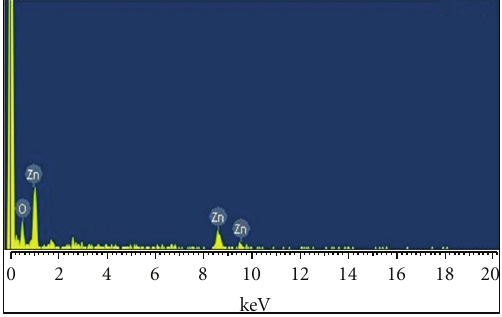
Figure 4: EDS spectrum of the ZnO